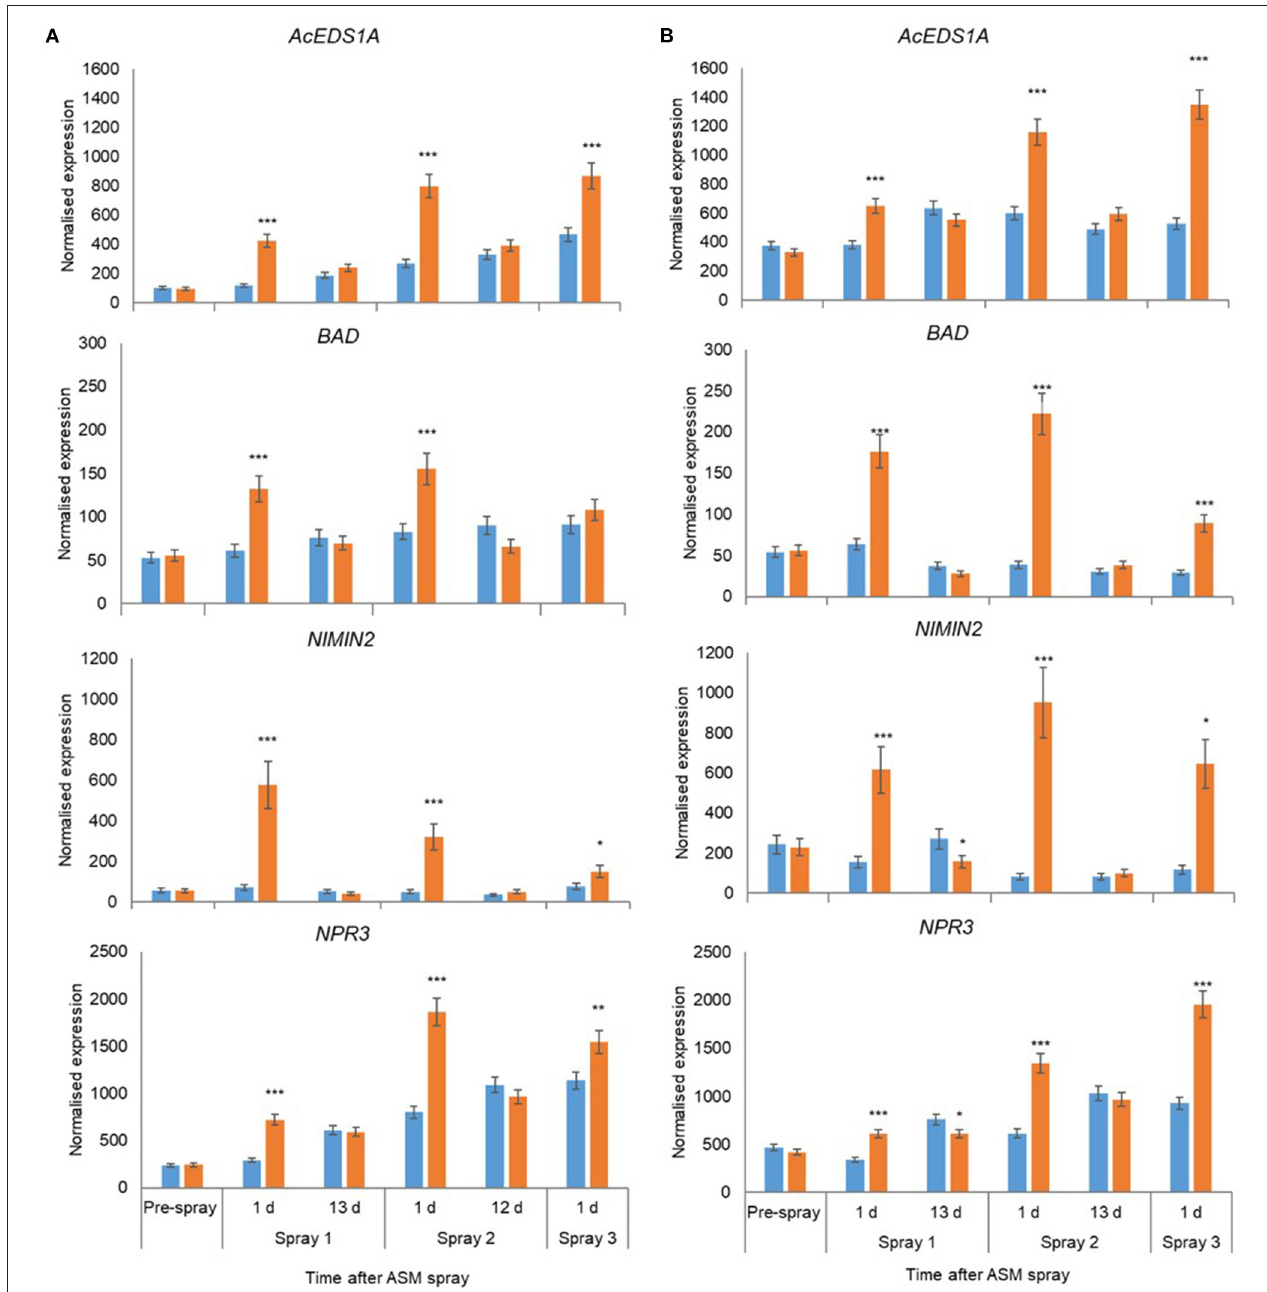
FIGURE 5 | Expression of AcEDS1A, BAD, NIMIN2, and NPR3 in Actinidia chinensis var. deliciosa ‘Hayward’ (A) and A. chinensis var. chinensis ‘Zesy002’ (B) in spring 2018, as measured by PlexSet® NanoString, and the Y-axis represents physical counts of the number of molecules expressed. Actigard (ASM) was sprayed on ‘Zesy002’ on 27 September, 10 October, and 24 October, and on ‘Hayward’ on 16 October, 31 October, and 13 November. Data were normalised against six references genes— 40s rRNA , actin , elongation factor , glyceraldehyde 3-phosphate dehydrogenase , protein phosphatase 2A , and ubiquitin-conjugating enzyme . Data were log 2 transformed for analysis, but are presented as back-transformed means. Asterisks above bars indicate significant treatment differences, where * < 0.05, ** < 0.01, and *** <